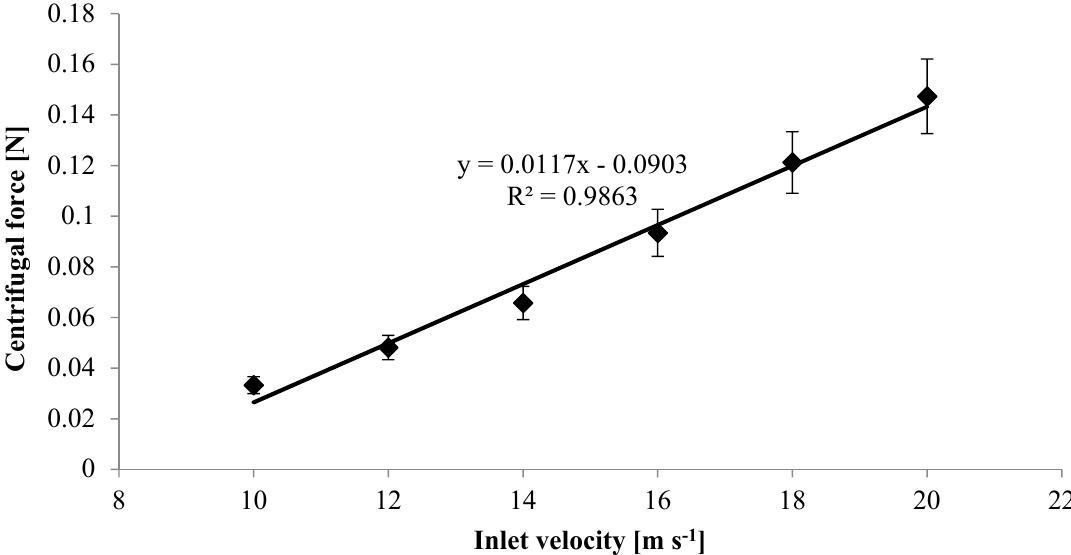
y = 0.0117x - 0.0903 R² = 0.9863